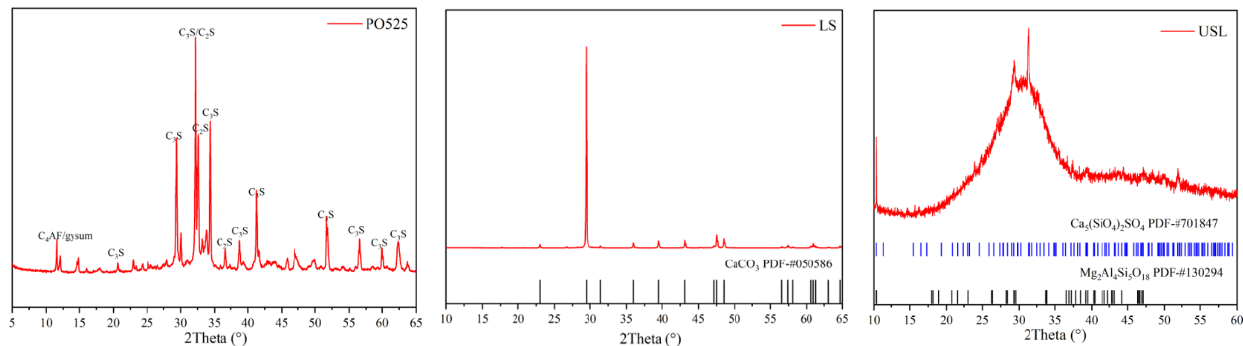
Figure 2. XRD analysis of P.O 52.5, HPS, and LS.